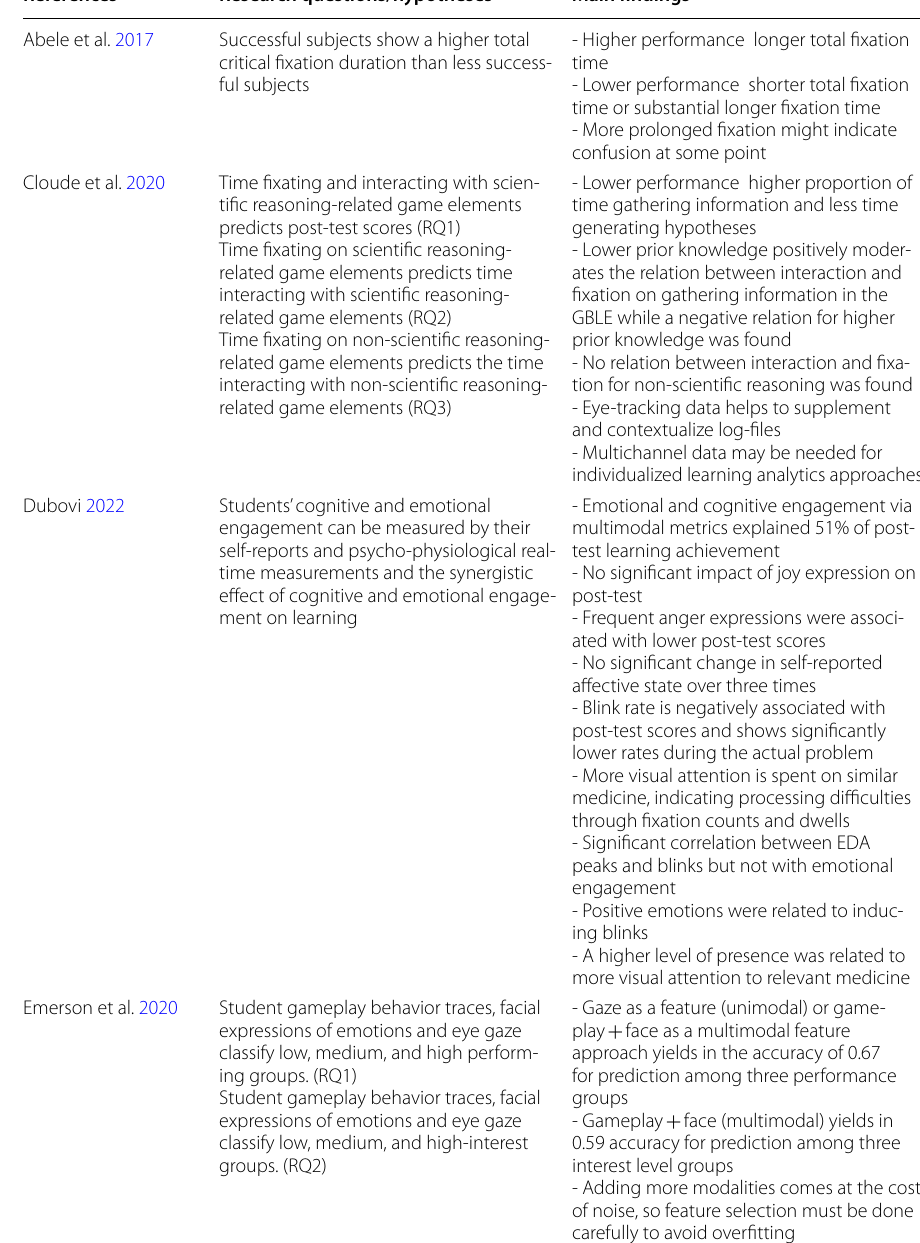
Table 5 Overview of research questions/hypotheses and main